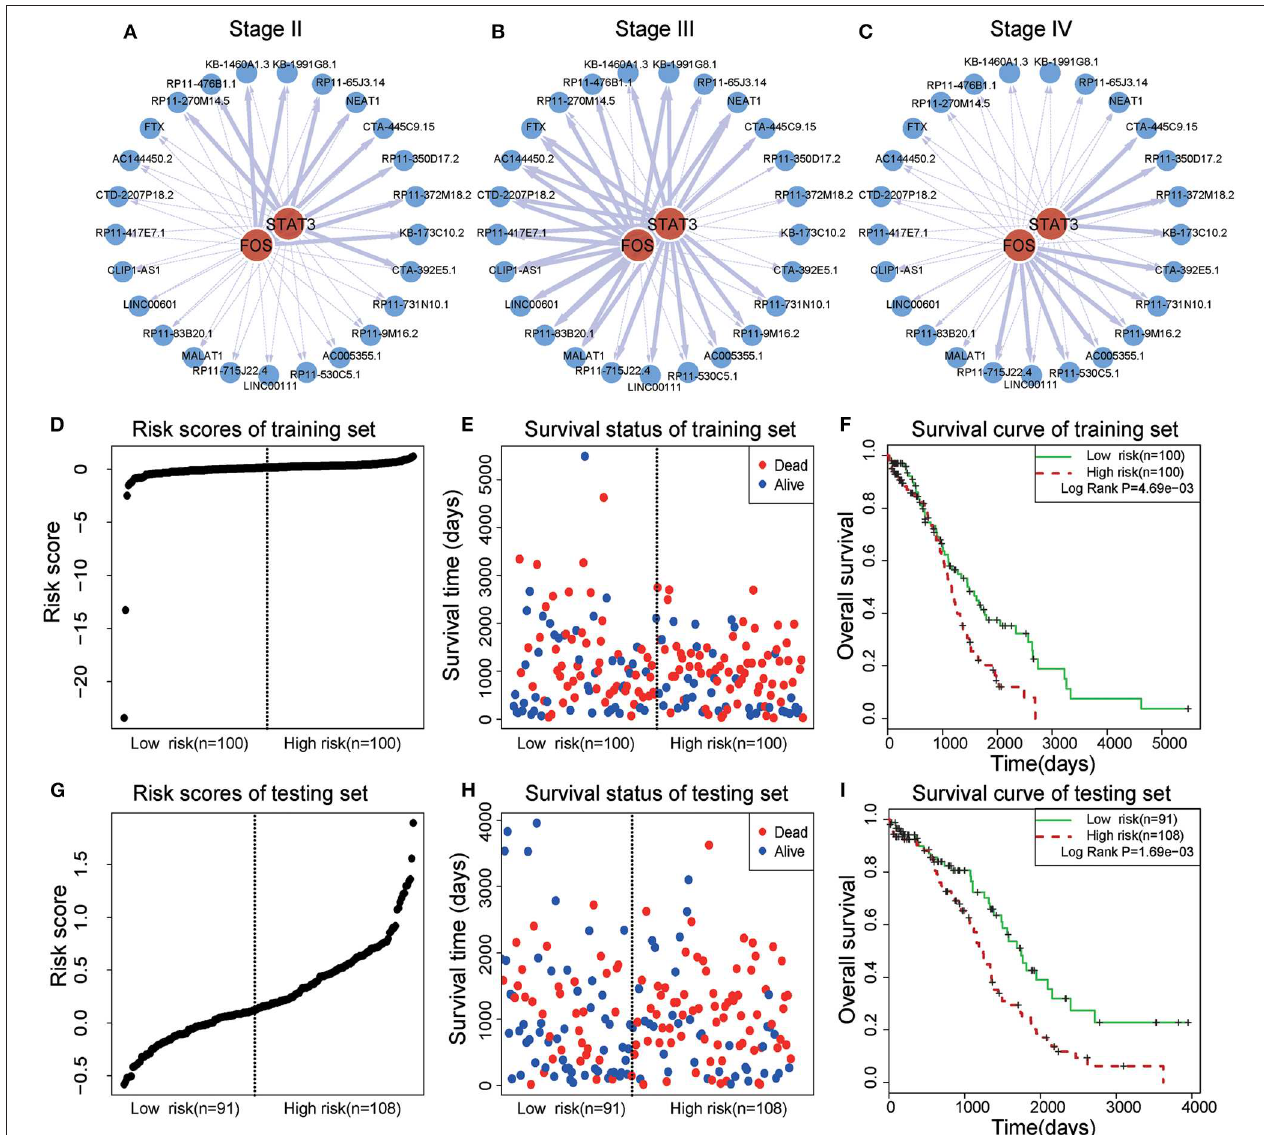
FIGURE 6 | Survival analysis of a STAT3-FOS-regulating TF-lncRNA clique. (A–C) Illustration of TF-lncRNA regulatory relationships in different OC stages. The TFs STAT3 and FOS selectively regulate different target lncRNAs. (D,E) The risk scores and survival status of this clique in the training dataset. (F) Kaplan-Meier survival curves revealed significant difference in survival between the two groups of patients in the training dataset. The high-risk group consisted of patients with higher risk scores and shorter survival time. (G,H) Risk scores and survival status of this clique in the testing dataset. (I) Kaplan-Meier survival curves for two groups in the testing dataset using the same risk score threshold as the training set. There was significant difference between high- and low-risk groups. TABLE 2 | Univariate and multivariate analysis of clinicopathological factors and the STAT3-FOS clique in 399 OC patients. Variables